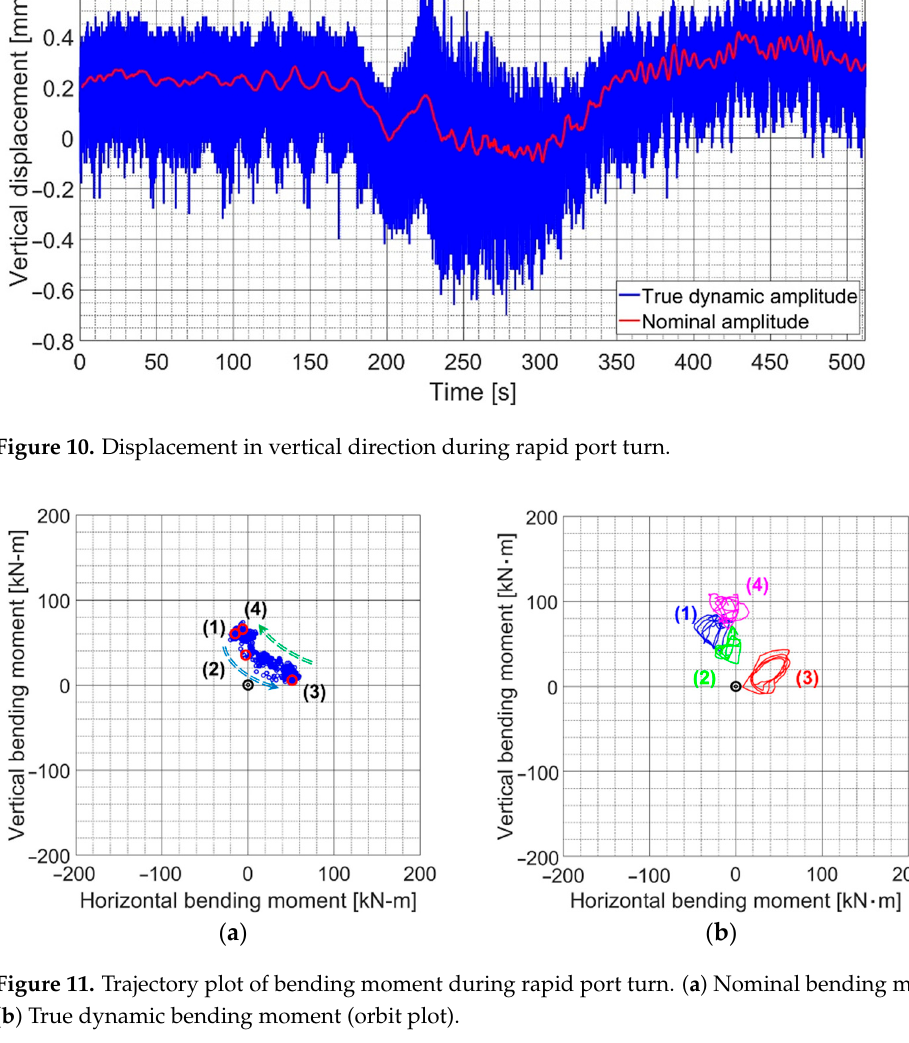
( b ) True dynamic bending moment (orbit plot).